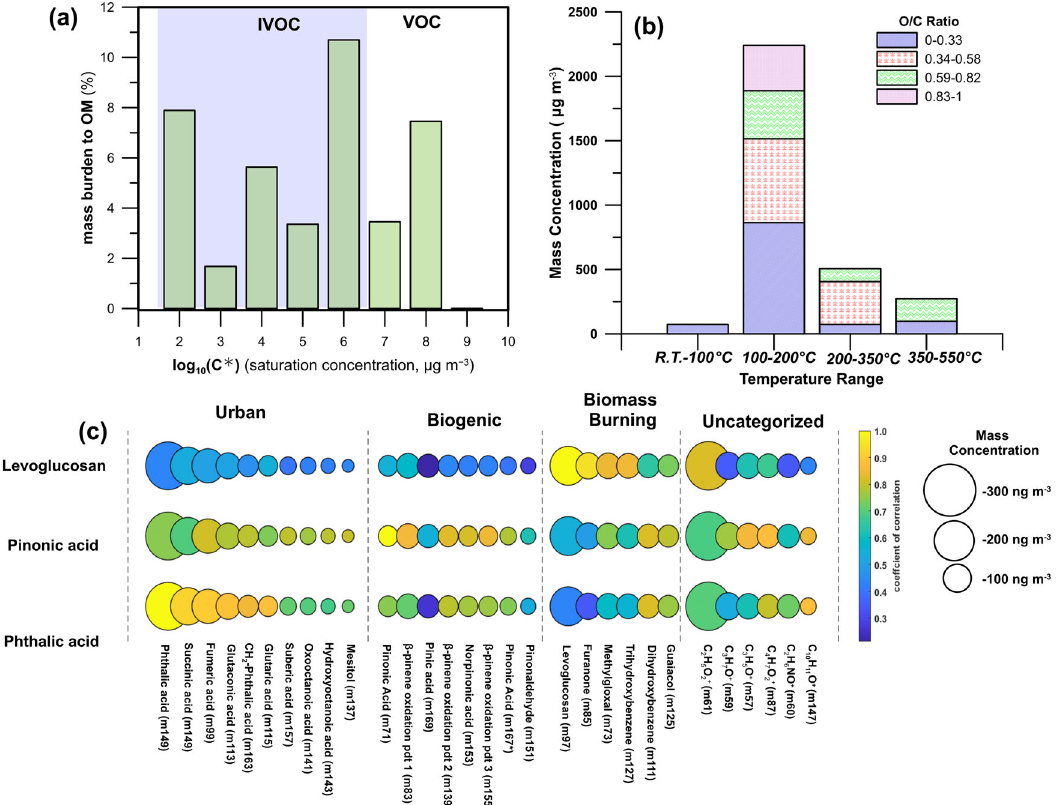
Fig. 2 Volatility, thermal pro fi le, and sources of the major ions. a Distribution pro fi le of the major organic ions binned into a volatility basis set (VBS). Note that the saturation concentration (C*) of each ion was corrected, assuming that the major ions detected were produced from dehydration (-H 2 O) after protonation of parent compounds. The ions with a log( C* ) > 7 µg m − 3 were deemed a thermal decomposition fragment of large molecules. The uncorrected saturation concentrations of the major ions are presented in Supplementary Fig. 3. b Histogram pro fi le of the top 30 ions based on temperature range with the inset of oxygen to carbon ratio ( O/C ). c Clustering of the organic tracers based on their sources. The size of the circles is proportional to the total measured mass concentrations (average over the 1-month measurement). The color of circles indicates the coef fi cient of correlation of each compound to phthalic acid (urban), pinonic acid (biogenic), and levoglucosan (BB) primary